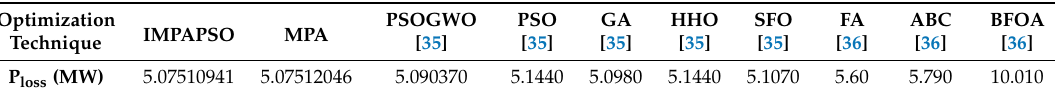
Table 1. IEEE 30-bus system’s first case objective performance.